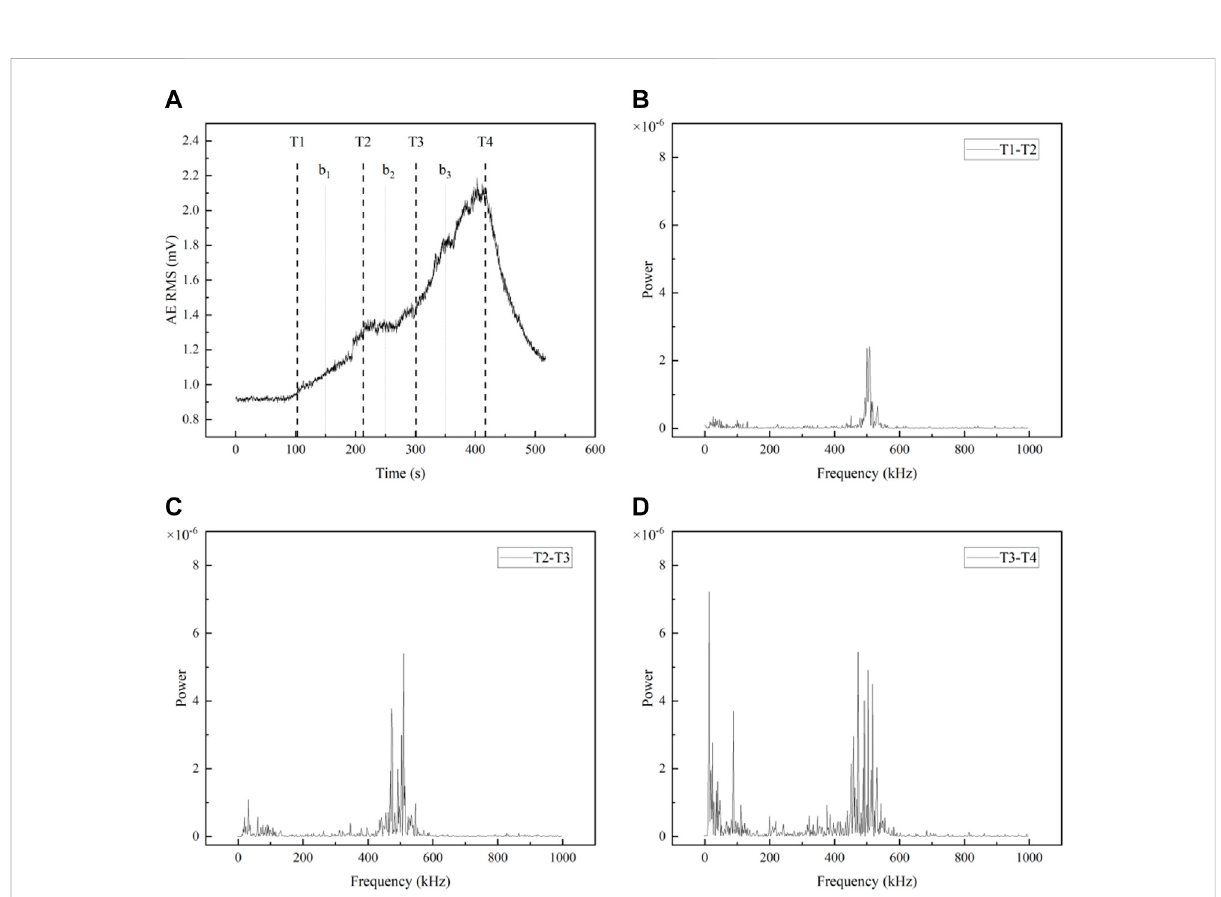
FIGURE 5 (A) AE RMS curves; (B – D) Frequency distributions of AE RMS in different